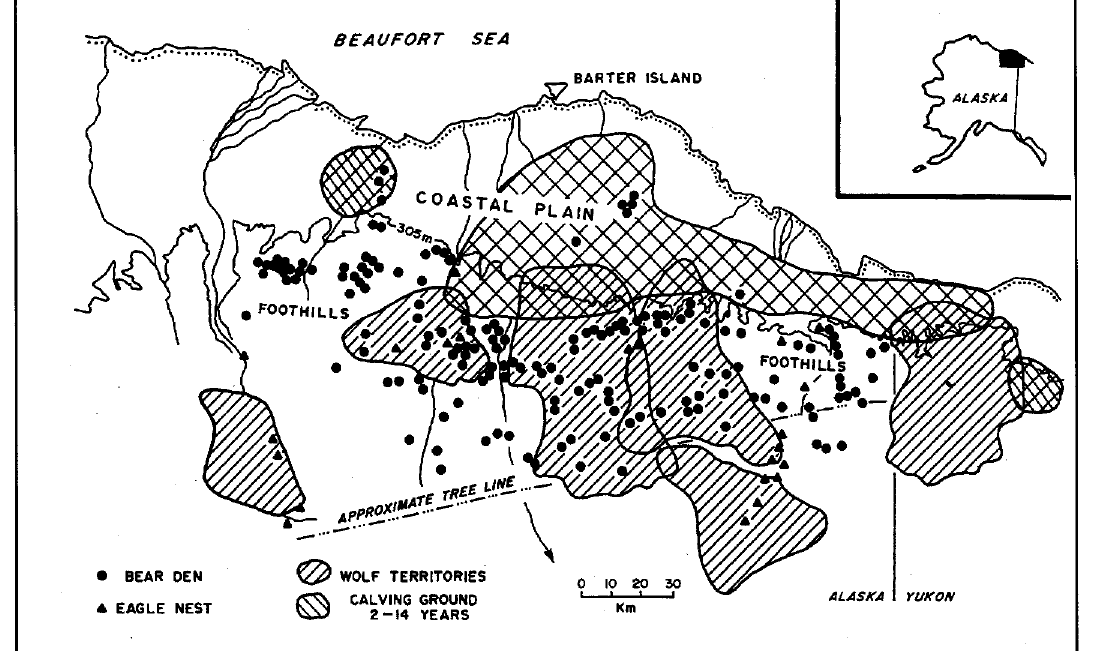
The composite distribution of the calving grounds of the Porcupine Herd 1972-85. Also shown are indexes to the distribution of the 3 primary predators, wolves, golden eagles (Aquila chrysaetas) and grizzly bears (Ursus aretes) 1982-85. The territories of the wolves in 1985 was mostly near tree line and in the foothills (92%) and the territories overlapped only 17% of the area of concentrated calving. The actual den sites or areas of con centrated summer activity were > 25 km from the southern edge of the calving distribution. The density of the wolves in 1984 and 1985 was very low, 1.4/1000km 2 . Adapted from Garner & Reynolds (1986.)